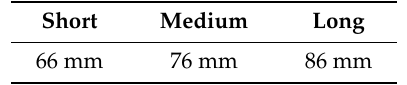
Table 2. Sleeve lengths used in